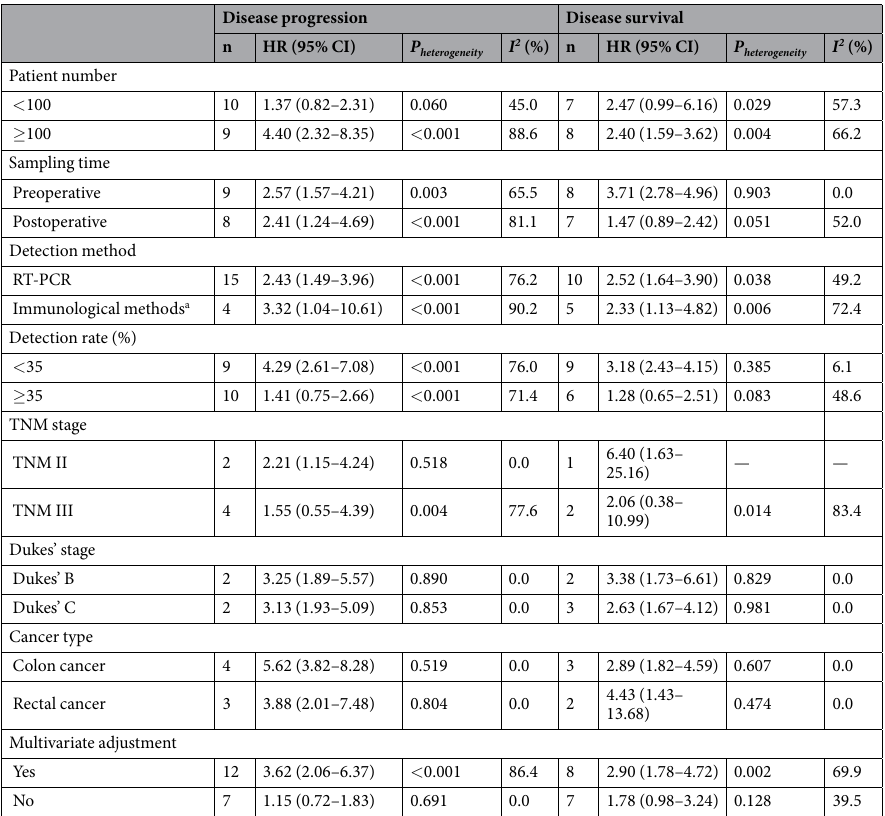
Table 3. Subgroup analyses of the prognostic effect of CTCs detected in the peripheral blood. a Immunological methods included CellSearch, Epispot and CMx platform. CellSearch is to use anti-EpCAM antibody coated on magnetic beads for cell capture and then identify (CK)8/18/19 + /DAPI + /CD45 − cells as CTCs by immunostaining. CMx platform is also a EpCAM-dependent method to capture CK20 + /DAPI + /CD45 −